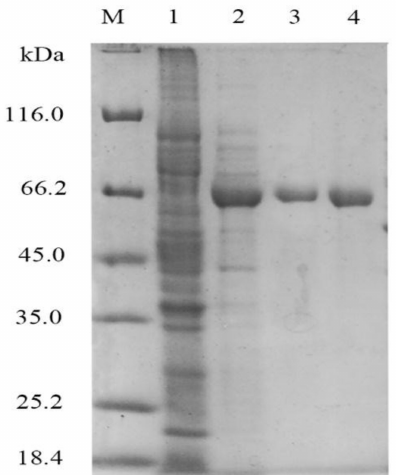
Figure 1. SDS-PAGE analysis of expressed Xanthomonas campestris pv. campestris (XcAS). Lane M shows the protein molecular weight marker; lane 1 shows total protein of E. coli JM109 cells harboring pET28a plasmid; lane 2 shows soluble supernatant of E. coli JM109 cells harboring the recombinant pET28a-xcas plasmid; lane 3 shows purified XcAS; and lane 4 shows purified XcAS after